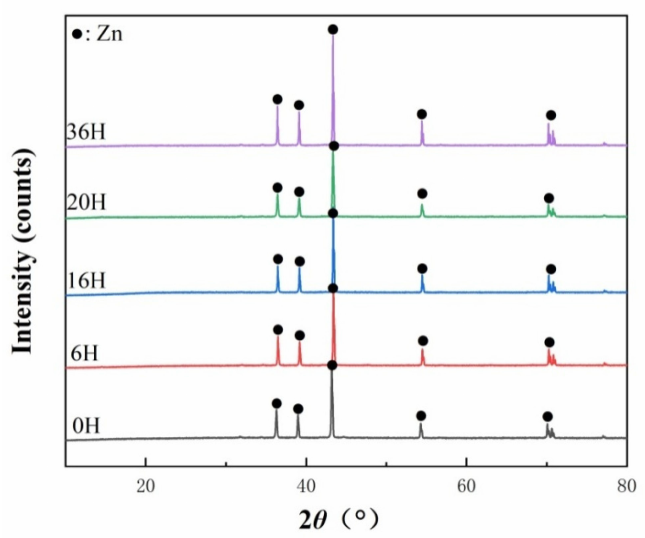
Figure 4. XRD patterns of WB zinc-based coatings prepared by using the paints stored for different periods, i.e., 0H, 6H, 16H, 20H,